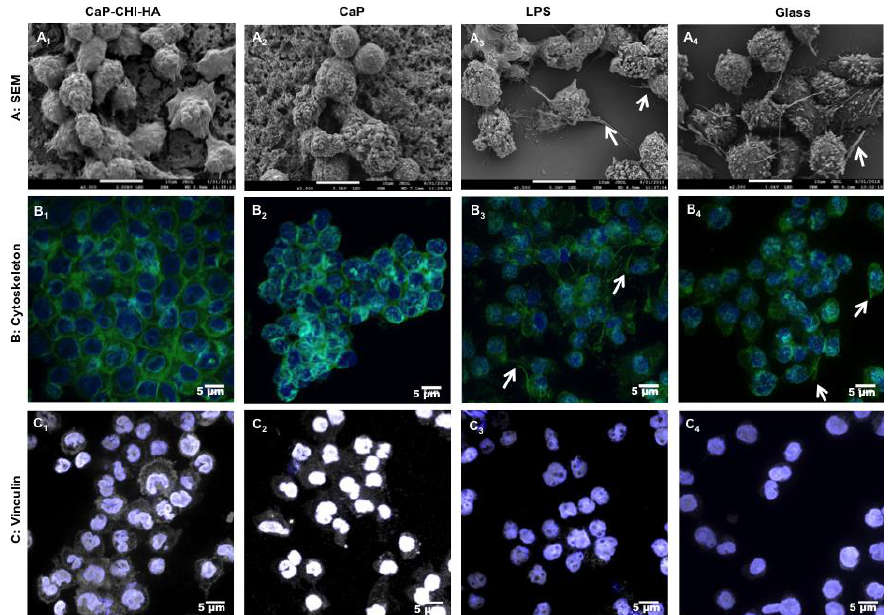
Figure 2. THP-1 morphology . Scanning electron microscopy ( A ) views after 24 h of contact with CaP-CHI-HA ( A 1 ), CaP ( A 2 ), stimulated with LPS ( A 3 ) or on glass ( A 4 ), highlighting (i) rounded cell morphology on CaP-CHI-HA and CaP (A 1 and A 2 , respectively) and (ii) cytoplasmic extensions (arrows) on LPS and glass (A 3 and A 4 , respectively) (scale bars indicate 10 μm). Confocal laser scanning microscopy ( B ) views of cytoskeleton and ( C ) vinculin after 24h of contact with CaP-CHI-HA ( B 1 and C 1 ), CaP ( B 2 and C 2 ), stimulated with LPS ( B 3 and C 3 ) and on glass ( B 4 and C 4 ), showing (i) concentrated F-actin at the membrane with a prominent vinculin distribution throughout the cytoplasm and the membrane in contact with CaP-CHI-HA, CaP (B 1 /B 2 and C 1 /C 2 , respectively) and (ii) arranged F-actin in spike-like protrusions (arrows) with a peri-nuclear distributed vinculin on LPS and glass (B 3 /B 4 and C 3 /C 4 , respectively). Green colors correspond to F-actin cytoskeleton, grey to vinculin, blue to nuclei and purple for merged vinculin/nuclei (scale bars indicate 5 µ